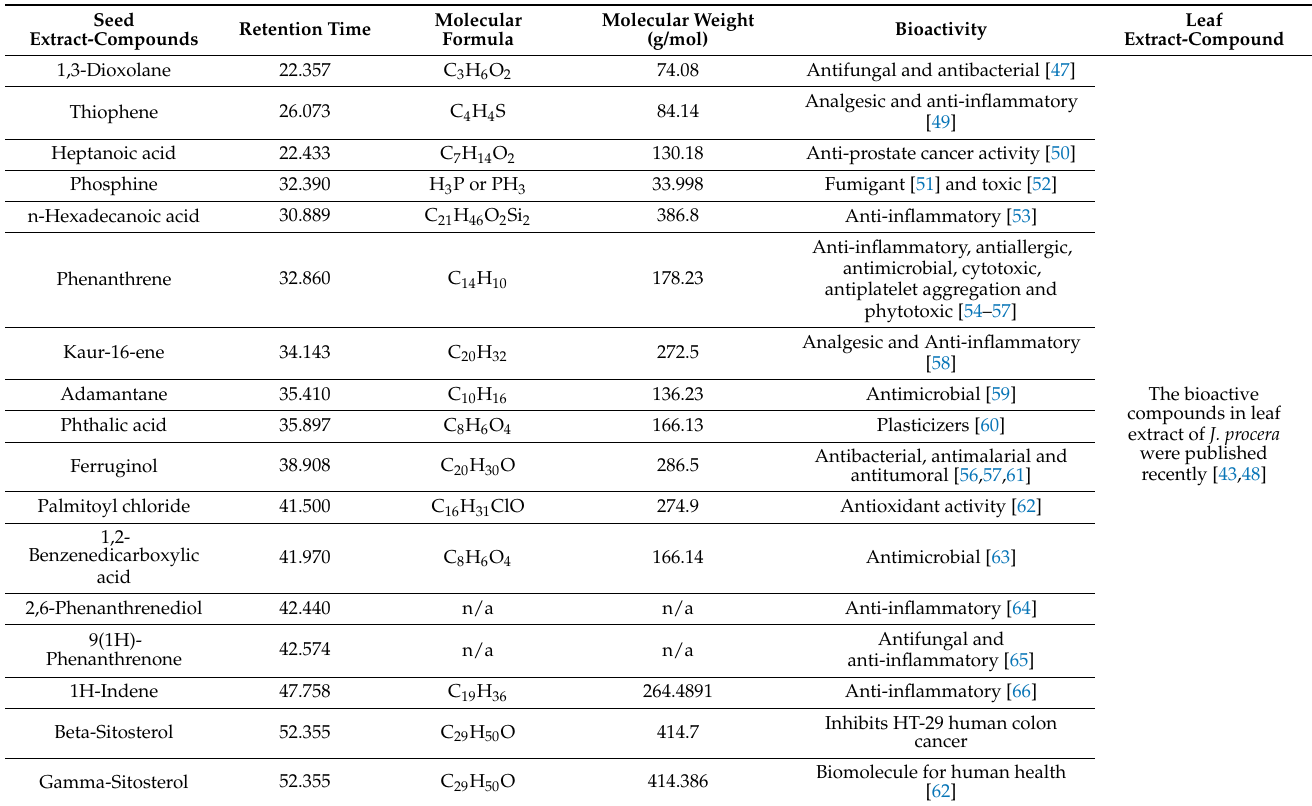
Table 5. Major and minor compounds in the seed and leaf extract of Juniperus procera detected by GC-MS and their biological